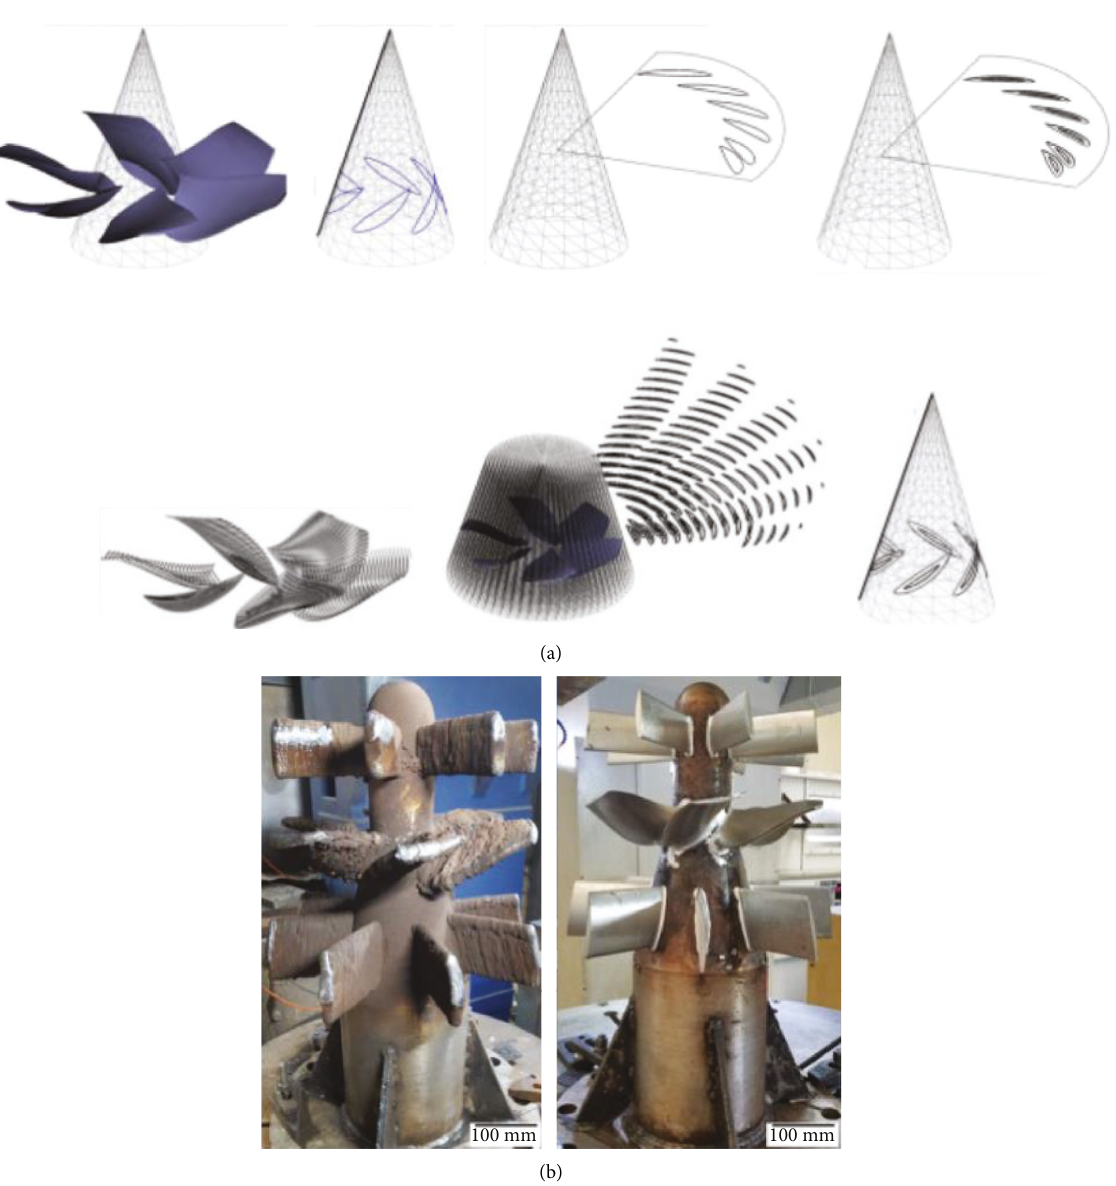
Figure 30: (a) Path planning on conical surfaces. (b) The final WAAM part (left) and its finished part